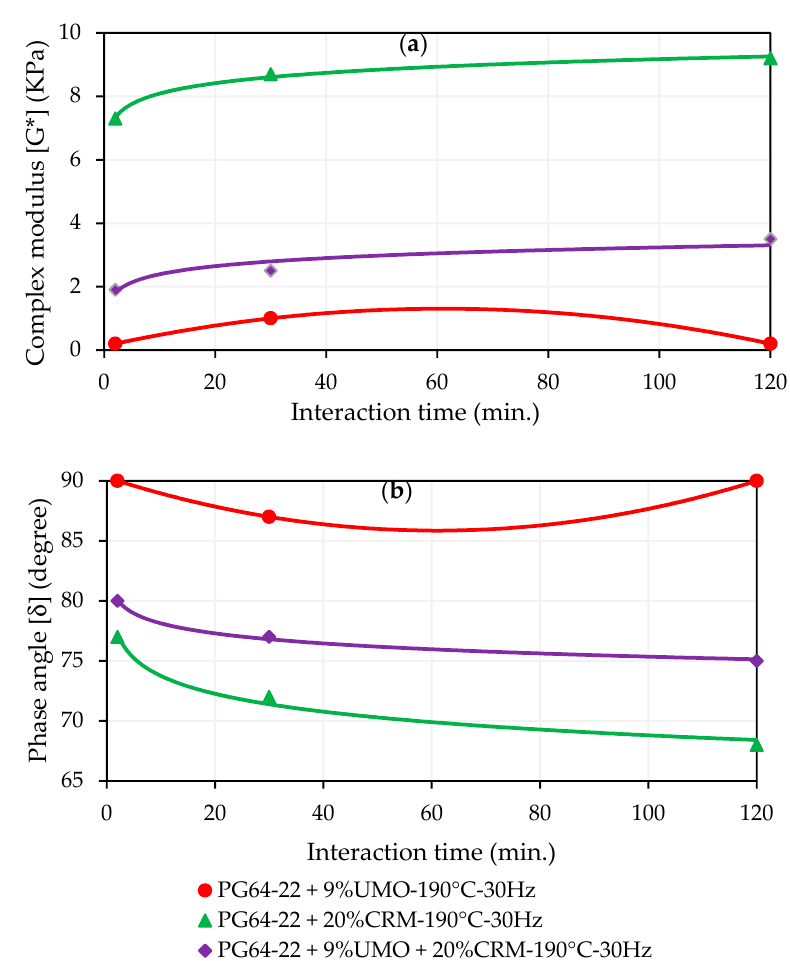
Figure 1. Rheological properties for PG 64-22 asphalt binder modified with CRM and UMO interacted at 190 ◦ C—30 Hz and measured at different interaction times: ( a ) G*; ( b ) δ [15].